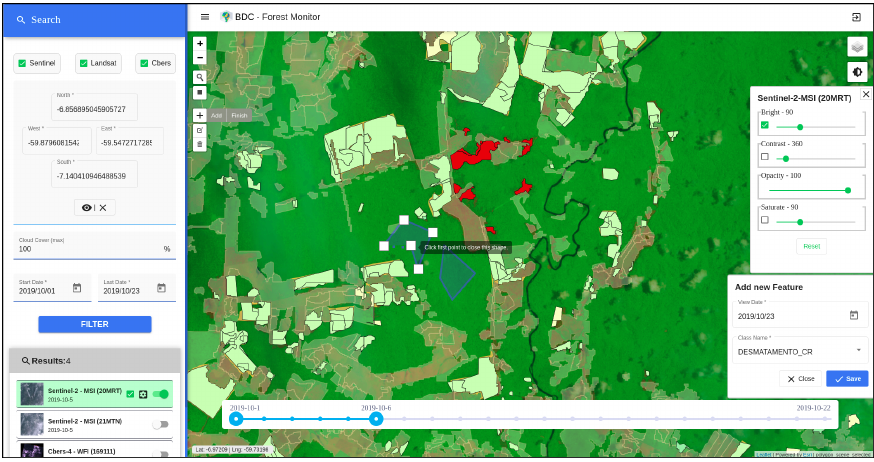
Figure 1: Forest Monitor Application.